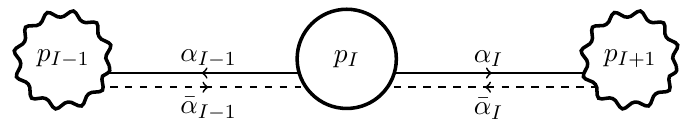
Figure 3 . A quiver diagram for a 1 / 4 BPS Wilson